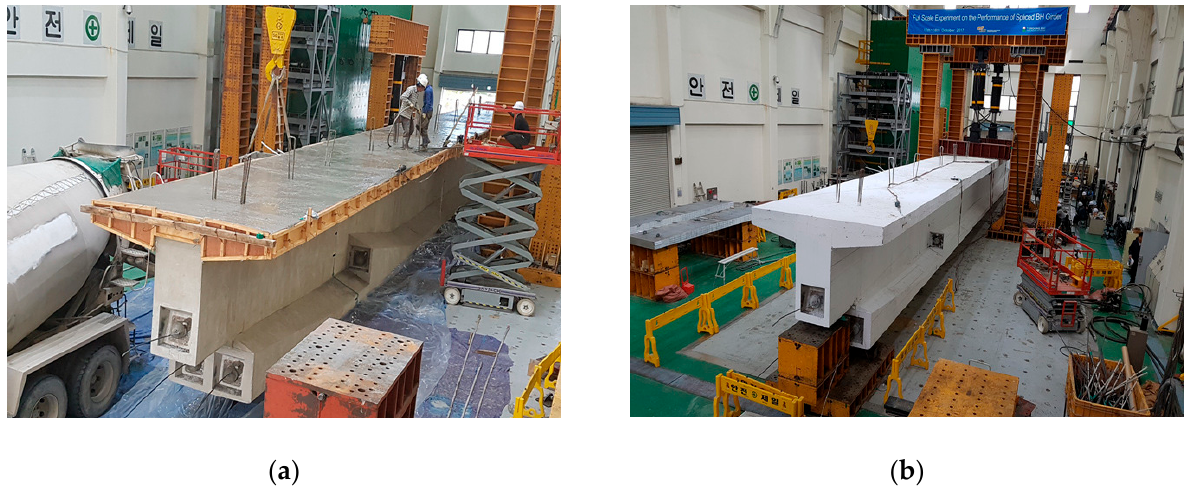
Figure 8. Variation of prestress force in tendon one of full-scale BH girder bridge prototype per tensioning step measured by OSPC strand.